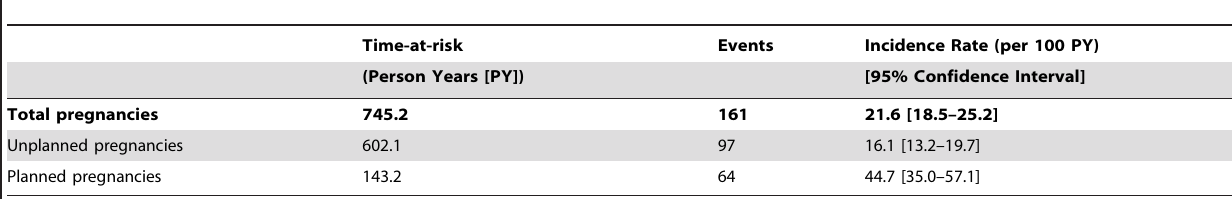
Table 2. Incidence of pregnancy in the cohort of South African women, August 2009–March 2011. Time-at-risk Events Incidence Rate (per 100 PY)